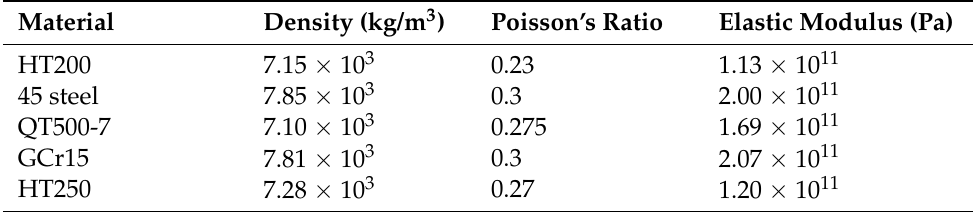
Table 4. Material parameters of direct-drive turntable.